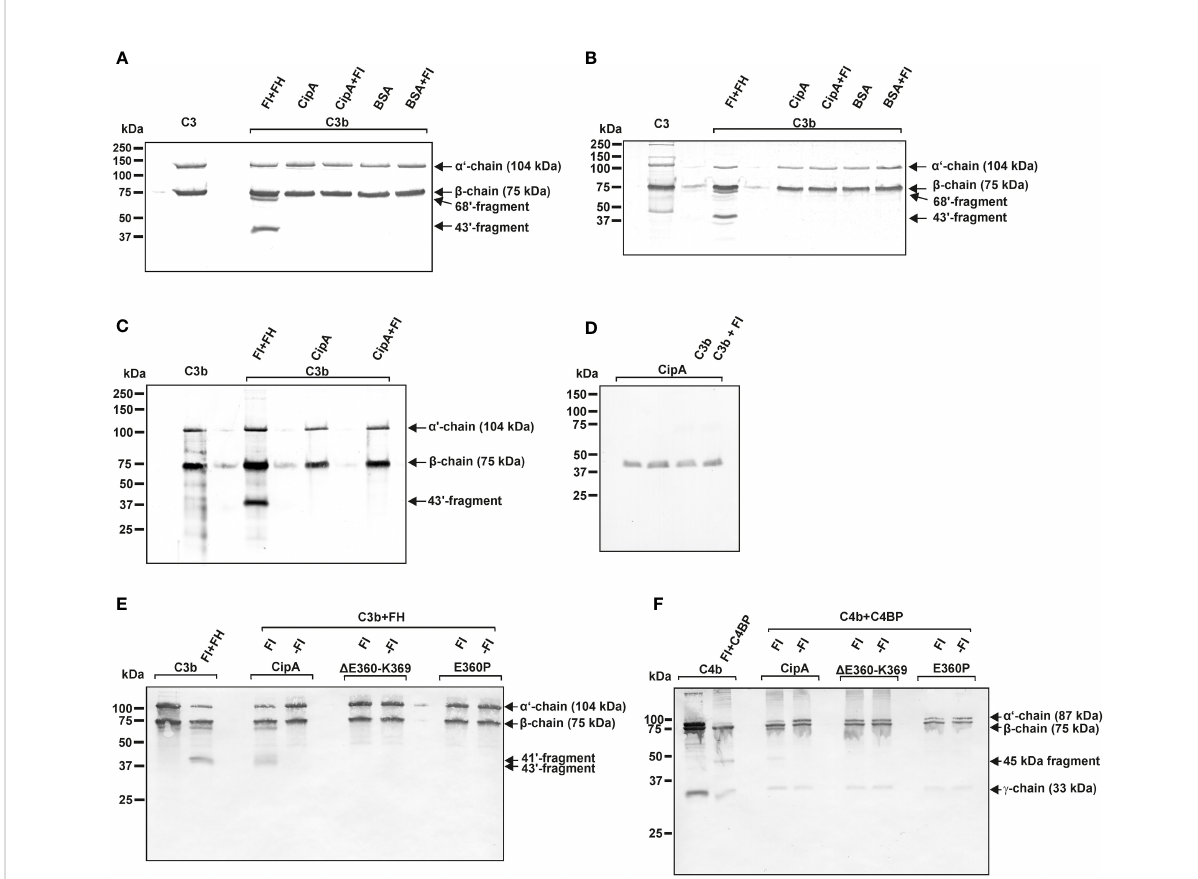
FIGURE 6 CipA lacks intrinsic proteolytic activity on C3b and C4b and formation of a quadripartite complex to inactivate C3b and C4b. Intrinsic proteolytic activity of CipA in FI-mediated inactivation of C3b was assessed by Western blotting (A – C) . CipA or BSA coated wells were incubated with C3b or with C3b and FI for 1 h (A) and 6 h (B) at RT or for 6 h at 37°C (C) . After termination, C3b degradation products were visualized by Western blotting employing a polyclonal anti-C3 antibody. Detection of CipA (D) in reaction mixtures shown in (C) by using an anti-CipA antibody (23). Formation of a quadripartite complex results in inactivation of C3b (E) and C4b (F) . Microtiter plates coated with CipA, CipA D E360-K369 or CipA E360P (5 ng/µl) were incubated in the absence (-FI) or presence of FI (+FI) . Thereafter, reaction mixtures containing C3b and FH or C4b and C4BP were added to the wells and were then subjected to SDS-PAGE and Western blotting. C3b and C4b degradation products were visualized by using an anti-C3 antibody and a mixture containing an anti-C4 and anti-C4d antibody. Control reactions containing C3b, FI, and FH as well as C4b, FI, and